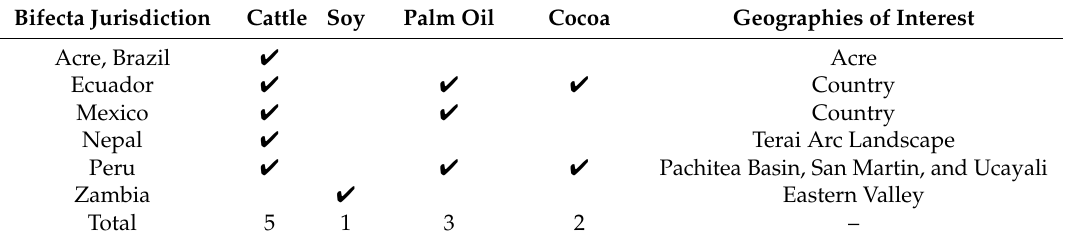
Table 2. All bifecta jurisdictions, including commodities of focus and geographies of interest 1